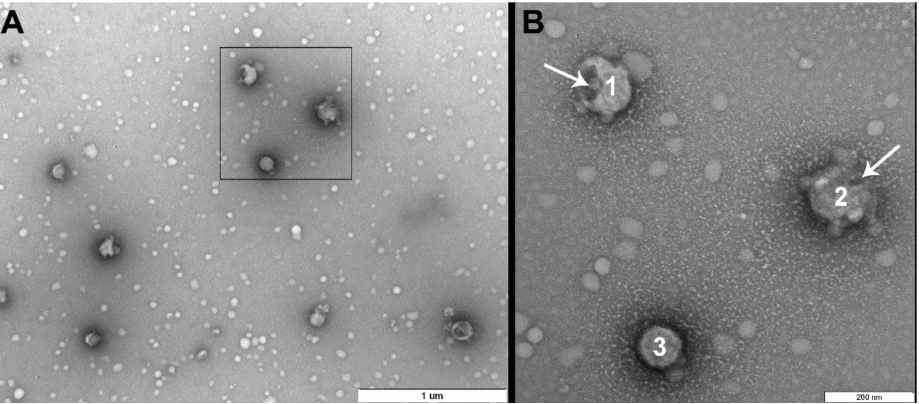
Figure 5. Virions after photodynamic inactivation (PDI) (4 µ M photosensitizer). ( A ) Low magnification (scale bar 1 µ m); ( B ) Magnified area denoted by black box in (A) (scale bar 200 nm). It is possible to distinguish two di ff erent forms of “bald” virus particles: smooth spherical virions (“3”) and virions with damaged membranes (“1” and “2”). Membrane damage or “dark windows” are marked with